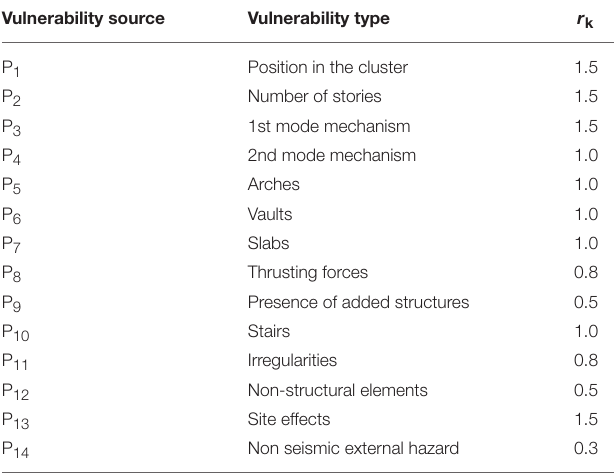
TABLE 1 | The 14 vulnerability sources taken into account for the vulnerability index